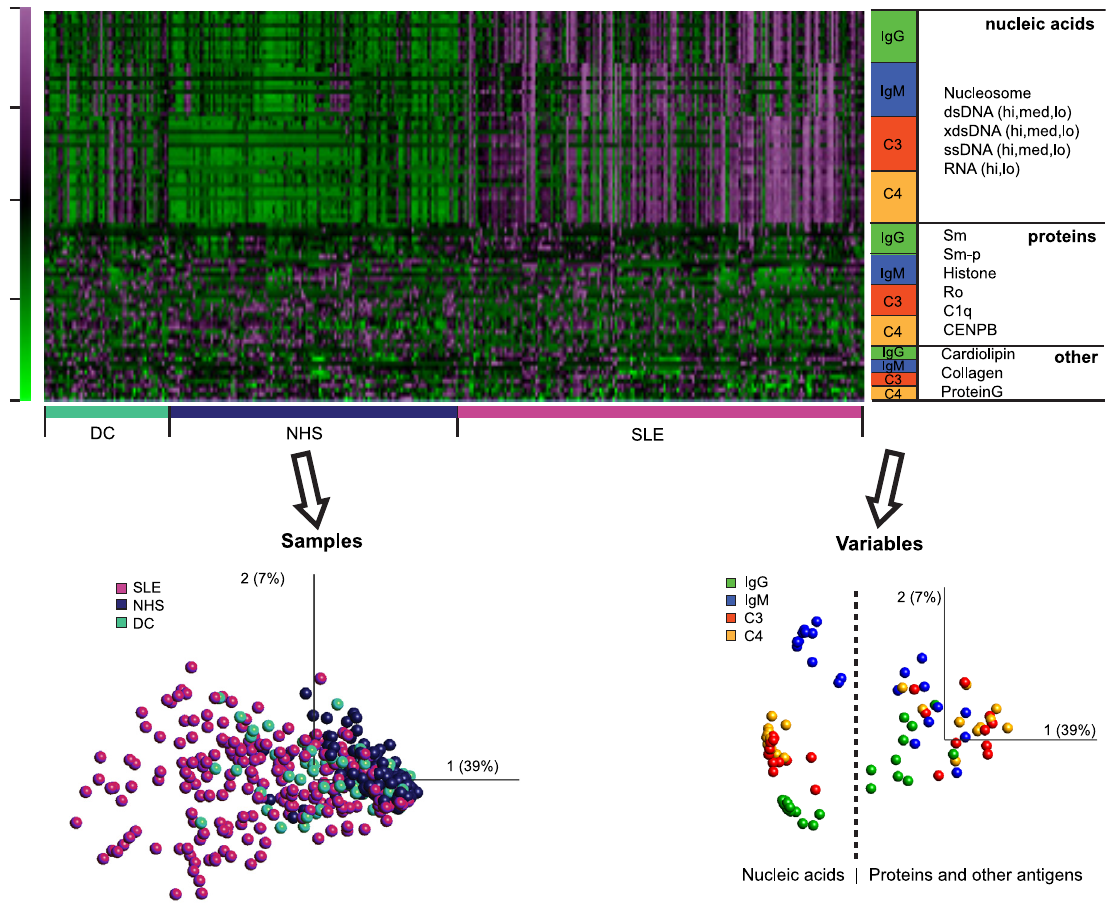
Fig 1. Heatmap and principal component analysis of the functional antibody profiling data. Samples are ordered as study groups. Variables are grouped by the molecular composition and the nature of the detected serum immunoglobulin or complement protein, the order of the particular antigens is shown and applies for each detected protein. PCA plot of samples shows the distribution of samples in the space of the first two components. The variable plot shows the contribution of the variables to the generation of this space, where distance and orientation from the zero origin define a particular interaction ’ s load in the first two principal components. Percentages in parenthesis indicate contribution of the indicated principal component to overall variability in the dataset. xdsDNA, ultrasound-fragmented dsDNA; CENPB, centromere protein B; Sm-p, peptide of Smith antigen D